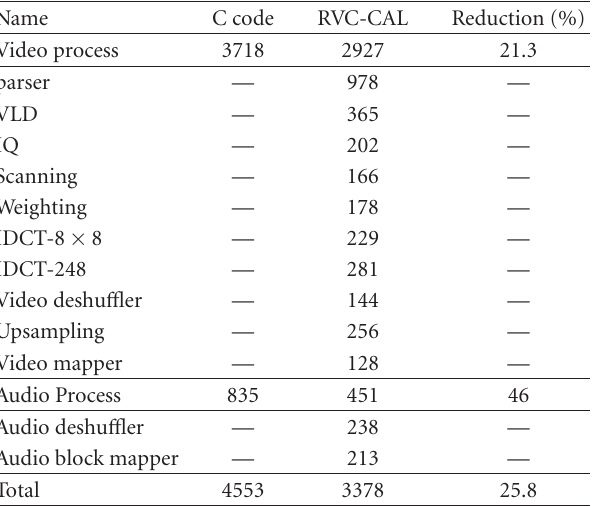
Table 3: Comparison between C code and RVC-CAL.